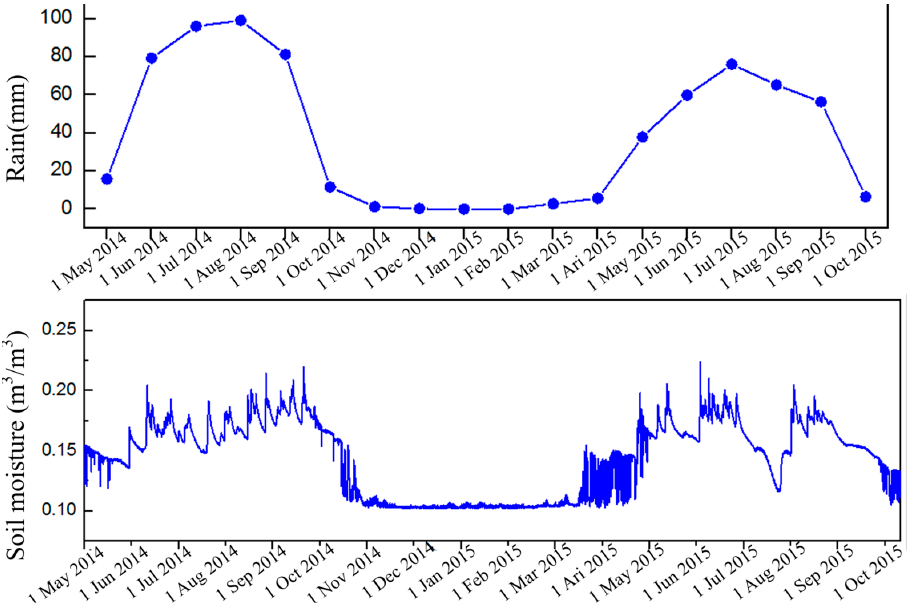
Figure 3. Soil moisture at a 10 cm soil depth and rainfall measured at Beiluhe weather station.